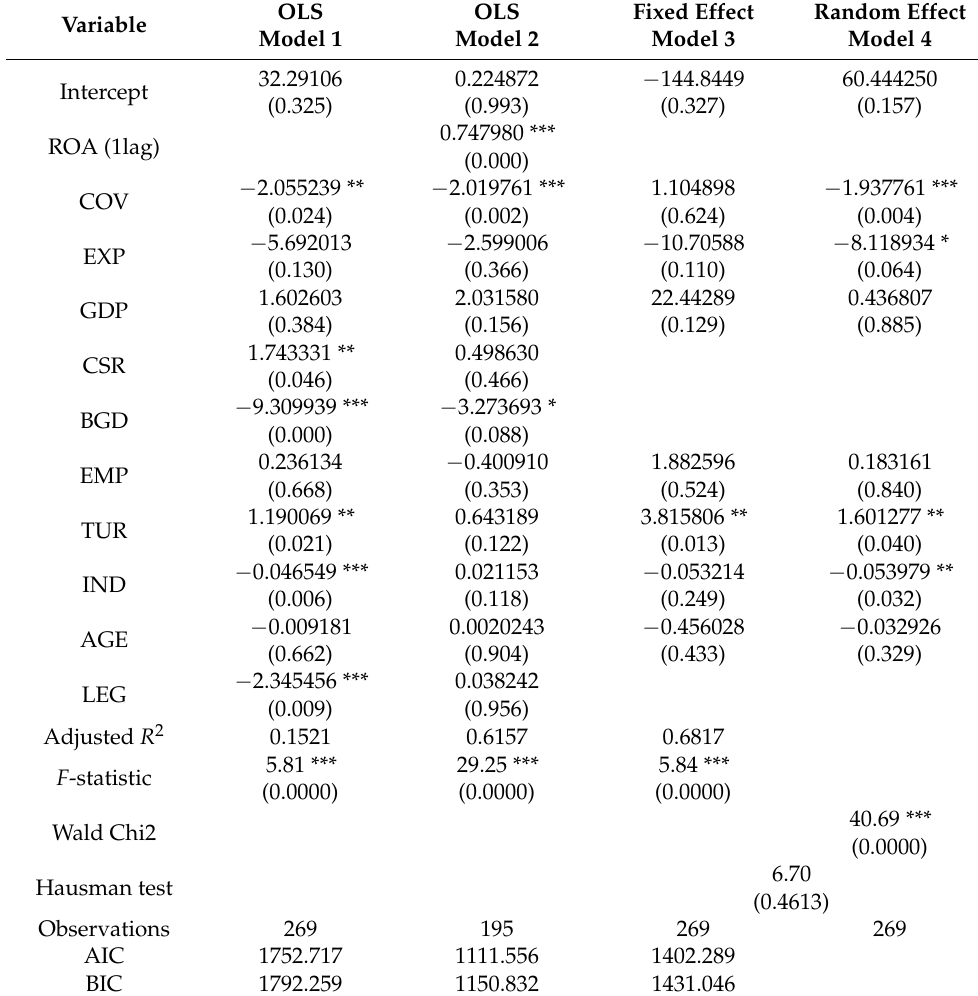
Table 3. Regression